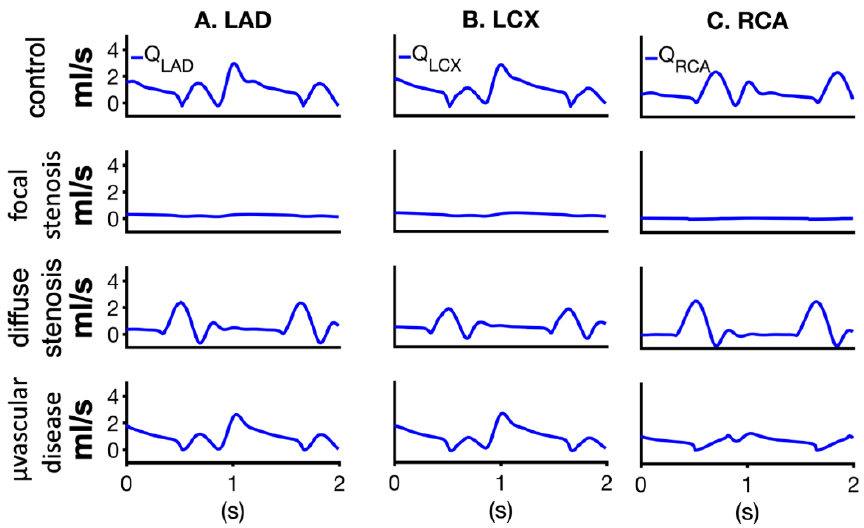
Figure 3. Flow profiles in the LAD (column A ), LCX (column B ), and RCA (column C ). In all columns, top row shows non-stenosed (control) model flow, second row shows flow under focal stenosis ( α = 90%) and the third row shows the flow under microvascular disease in the absence of focal stenosis ( = 100%; 𝜖 = 2.33).